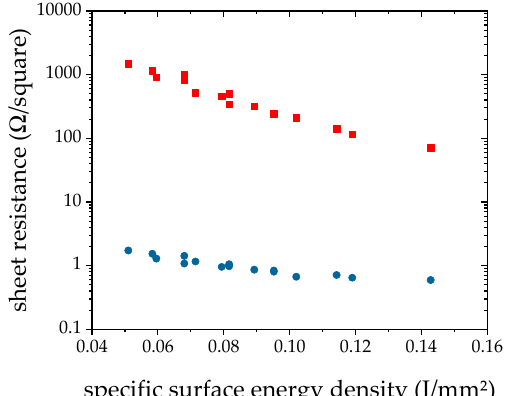
Figure 1. Comparison of sheet resistance of n-type bismuth telluride when processed in air (red squares) and Ar (<20 ppm O 2 -content < 20 ppm; blue dots) atmosphere. Power P = 100 W, Scan velocity v = 2.5–4 m/s, spot diameter d = 562 µm, hatch spacing h = 0.3–0.5 mm.